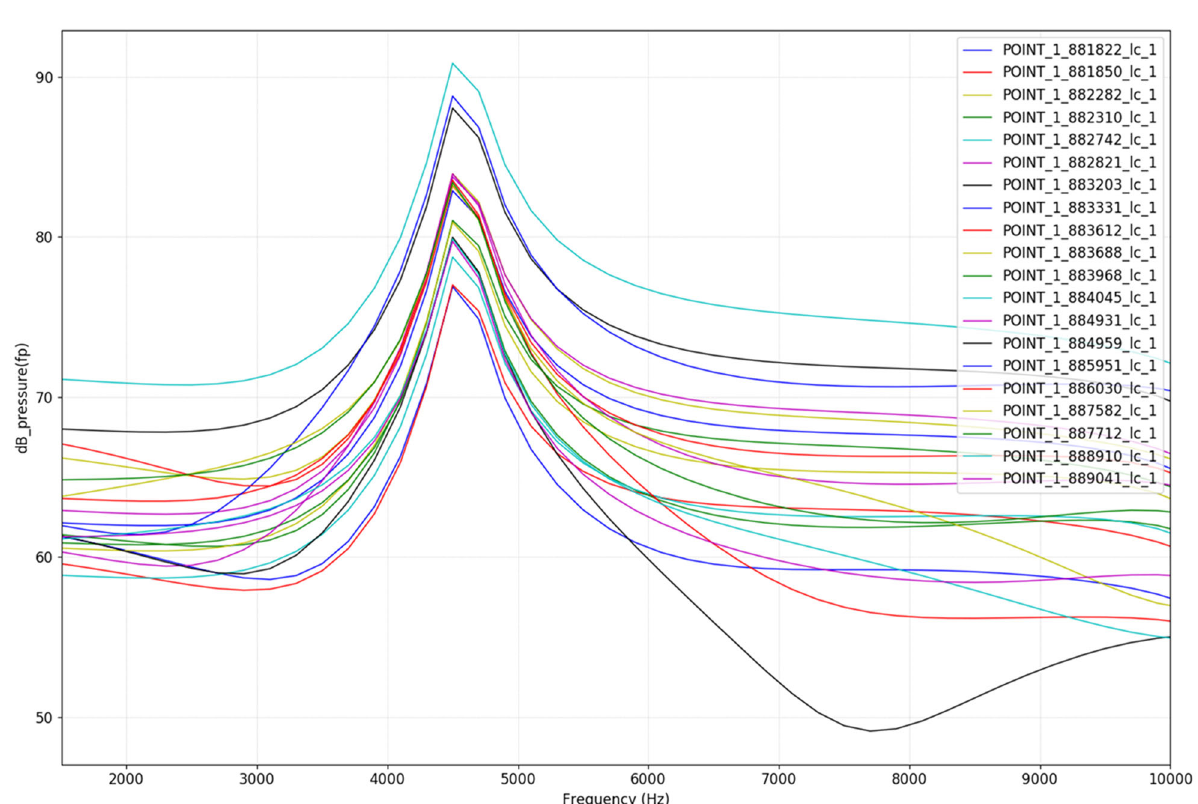
Fig. 5 Sound measurements from the microphone array (dB). The measurements for each microphone are displayed in different